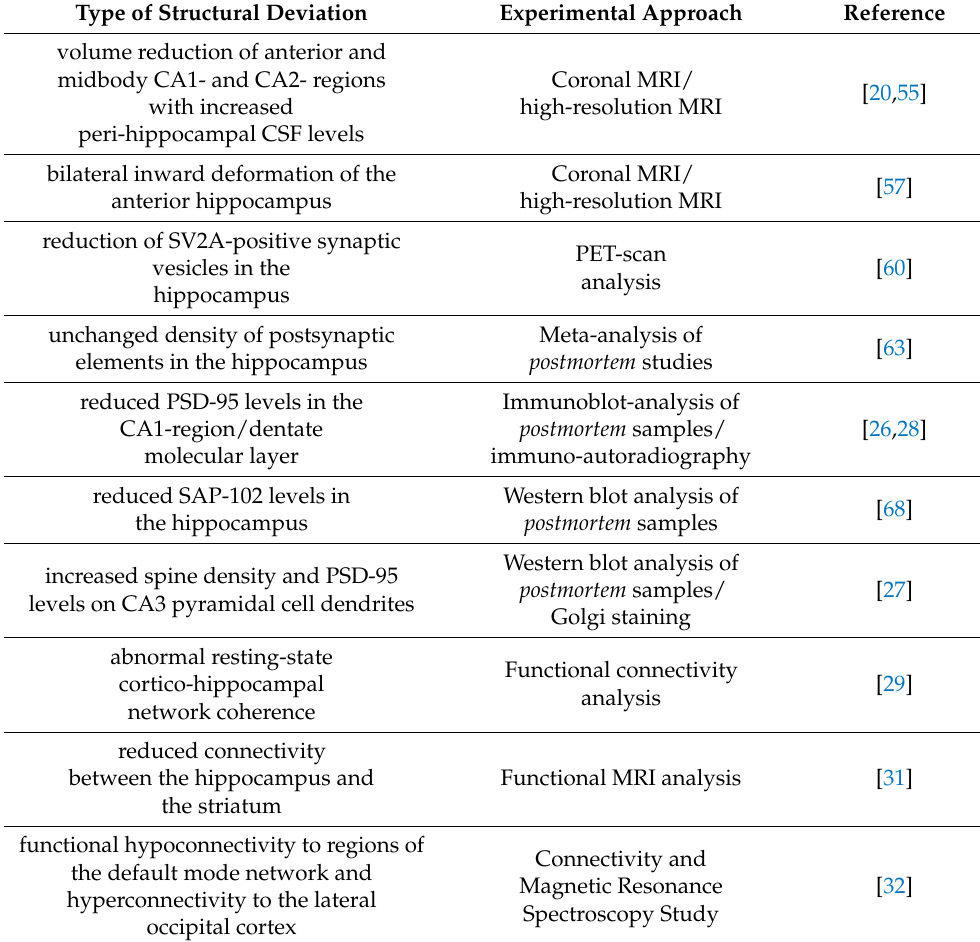
Table 1. Cont. Type of Structural Deviation Experimental Approach